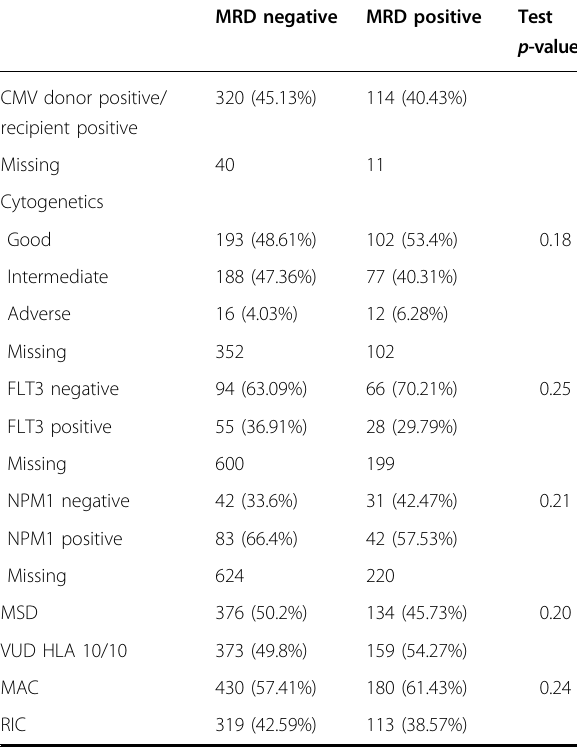
Table 2 Transplant engraftment and toxicity in MRD negative vs. MRD positive